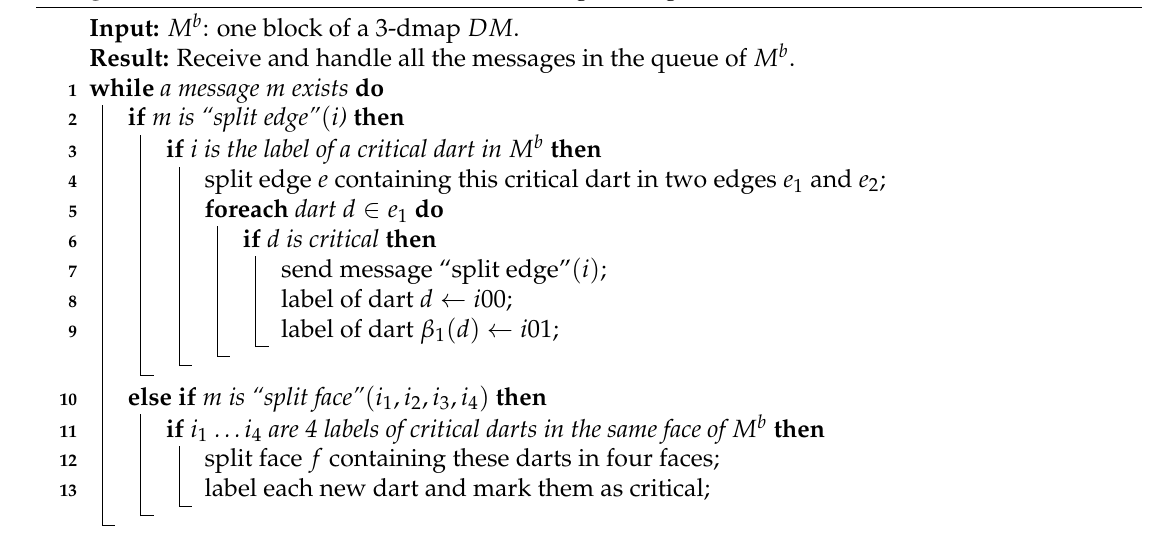
Figure 6. Block M 2 of the 3-dmap DM shown in Figure 5, for the two steps of the division of the face with critical darts labeled a , ..., d . ( a ) After the split of the four edges. ( b ) After the split of the face. Management of messages. At the end of Algorithm 1, when a hexahedron h has just been subdivided, messages sent from other blocks are read and handled (line 19). This is achieved in Algorithm 2. The main principle of this algorithm is to read all the messages that arrived in the message queue associated with block M b . There are only two different types of messages: “split edge” and “split face”. For both types of message, we split the corresponding cell, while using the same rules for labeling and re-labeling of critical darts as the rules used in Algorithm 1 in order to preserve the compatibility between labeling of different blocks. This guarantees the global consistency of the 3-dmap DM , since we apply exactly the same operations on the same cells in each different block of DM . Algorithm 2: Receive and handle all the messages of a given